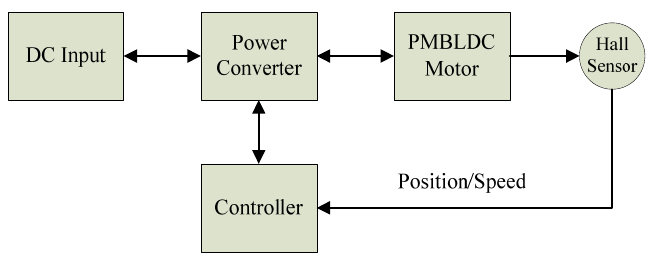
Figure 1. Components of the PMBLDC drive.